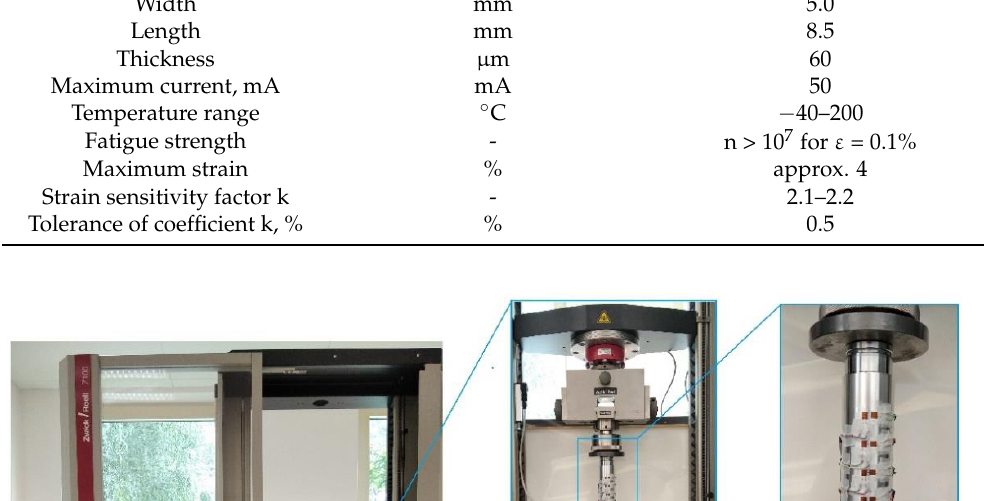
Figure 5. Strain measurement stand. Table 2. Parameters of the TF-5/350 strain gauge.